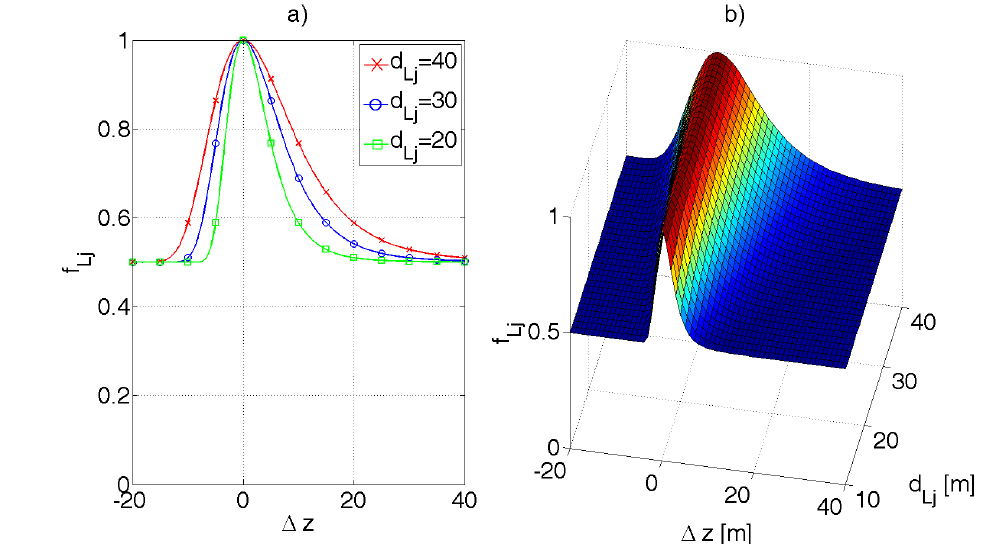
Figure 14. ( a ) An example of the f values of a = 0 . 5 and σ substituted). ( b ) A 3D plot of f of the function widens as the compared distances